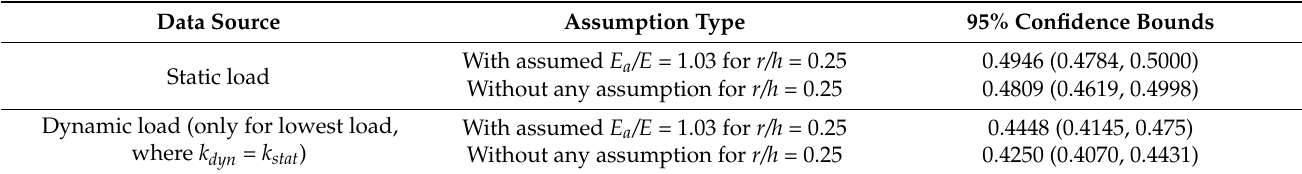
Table 11. Results of Poisson ratio with and without assumed for r/h = 0.25 E a /E = 1.03. Analogously for dynamic loads method was applied.